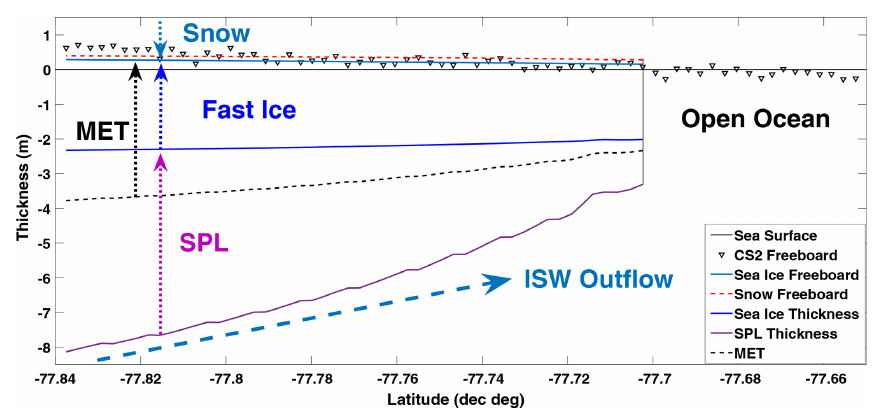
Figure 2. Spline-interpolated drill-hole-measured sea ice and snow freeboard, as well as fast ice, SPL and mass equivalent thicknesses (METs) relative to the zero-level reference sea surface from November 2017 with CS2 freeboard on the 15 November 2017. The McMurdo Ice Shelf is located in the south (left-hand side) of this profile at an approximate latitude of − 77.84 ◦ .